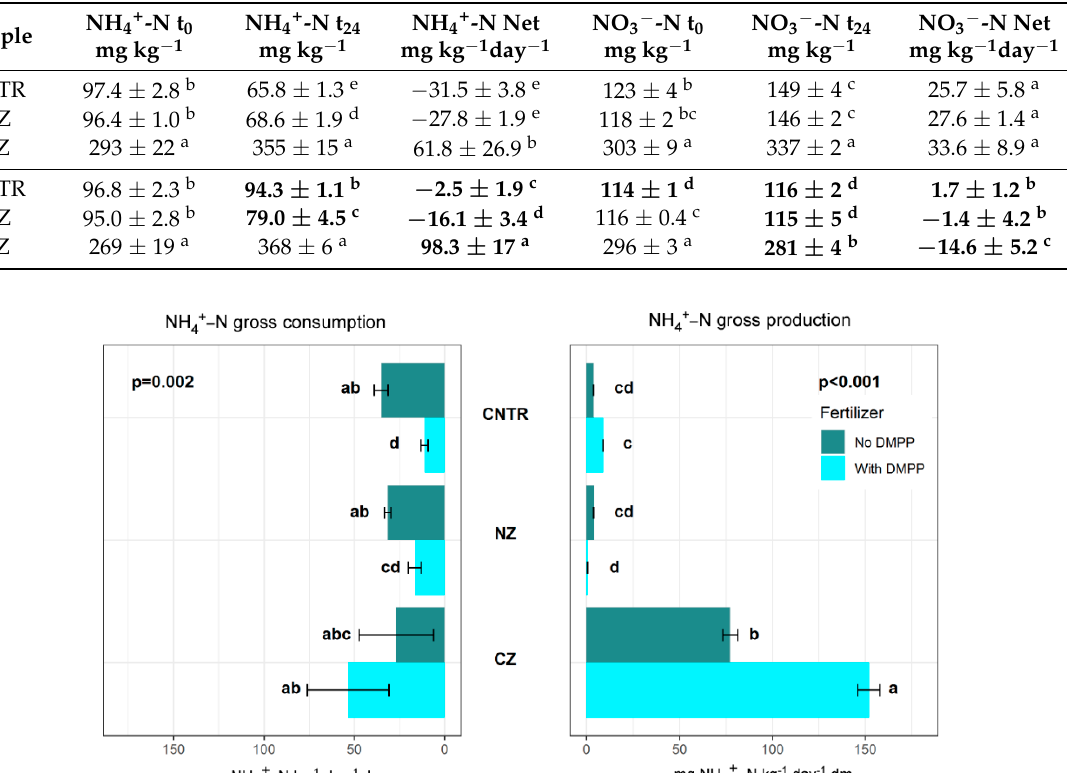
Table 2. NH 4+ -N and NO 3 − -N concentrations at the beginning (t 0 ) and end (t 24 ) of the incubation. Net rates are calculated as indicated in Equation (3). Values are expressed as mean ± standard deviation (4 replicates). Different superscript letters express significant differences ( p < 0.05) between treatments as a result of ANOVA (for NH 4+ -N t 0 ), Kruskal-Wallis (other variables), and Tukey-HSD statistical tests. Values in bold highlight the significant effect of DMPP.